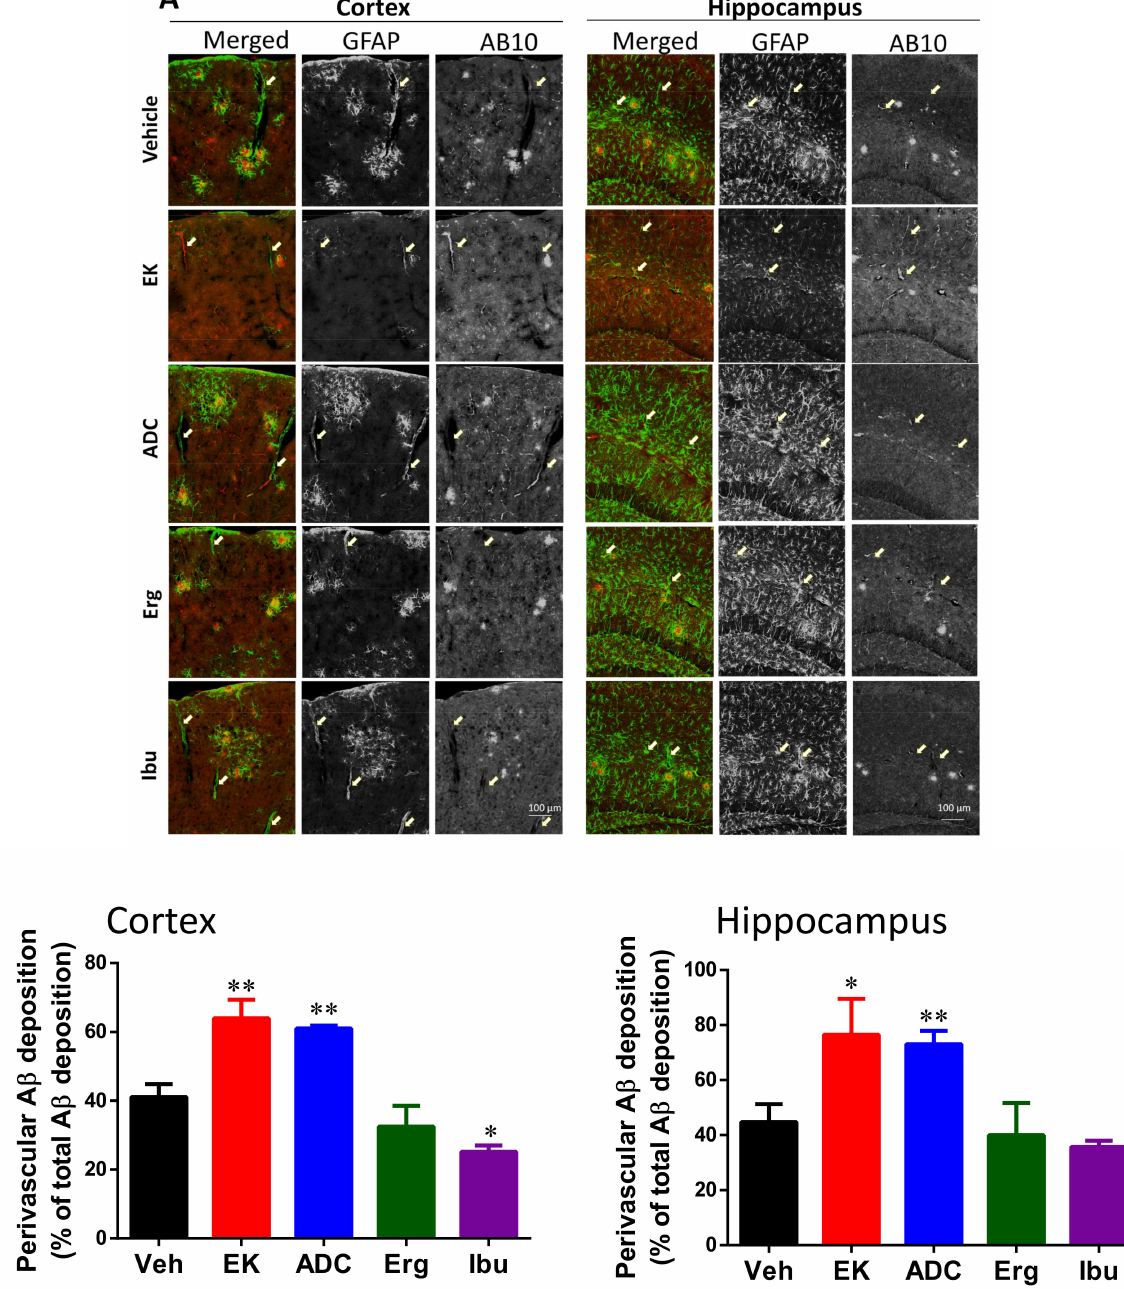
Figure 4. EK100 and antrodin C increase perivascular A β deposition in APP/PS1 mice. APP/PS1 transgenic mice orally administered vehicle (Veh) or EK100 (EK), antrodin C (ADC), ergosterol (Erg), and ibuprofen (Ibu) (30 mg · kg − 1 · day − 1 , each n = 6) for 1 months, and then astrocytes and microglia were immunostained GFAP and Iba-1 antibodies, respectively. ( A ) The representative immunostaining images of GFAP and AB10 in the cortex and hippocampus are shown. Scale bar: 100 µ m. Arrows indicate the representative perivascular area. ( B ). The percentage of perivascular A β deposition to total A β deposition is calculated by MetaMorph image analysis software and shown. The results are the mean ± S.E.M. Significant differences between the Veh group and the other groups are indicated by *, p < 0.05; **, p <